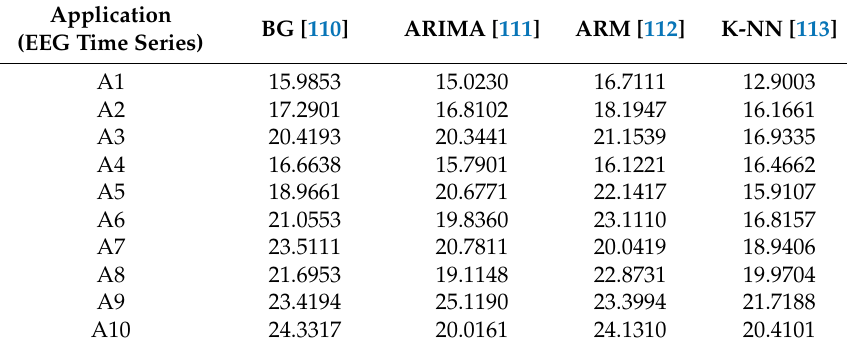
Values represent the mean MAE from 30 runs. Best values are in bold